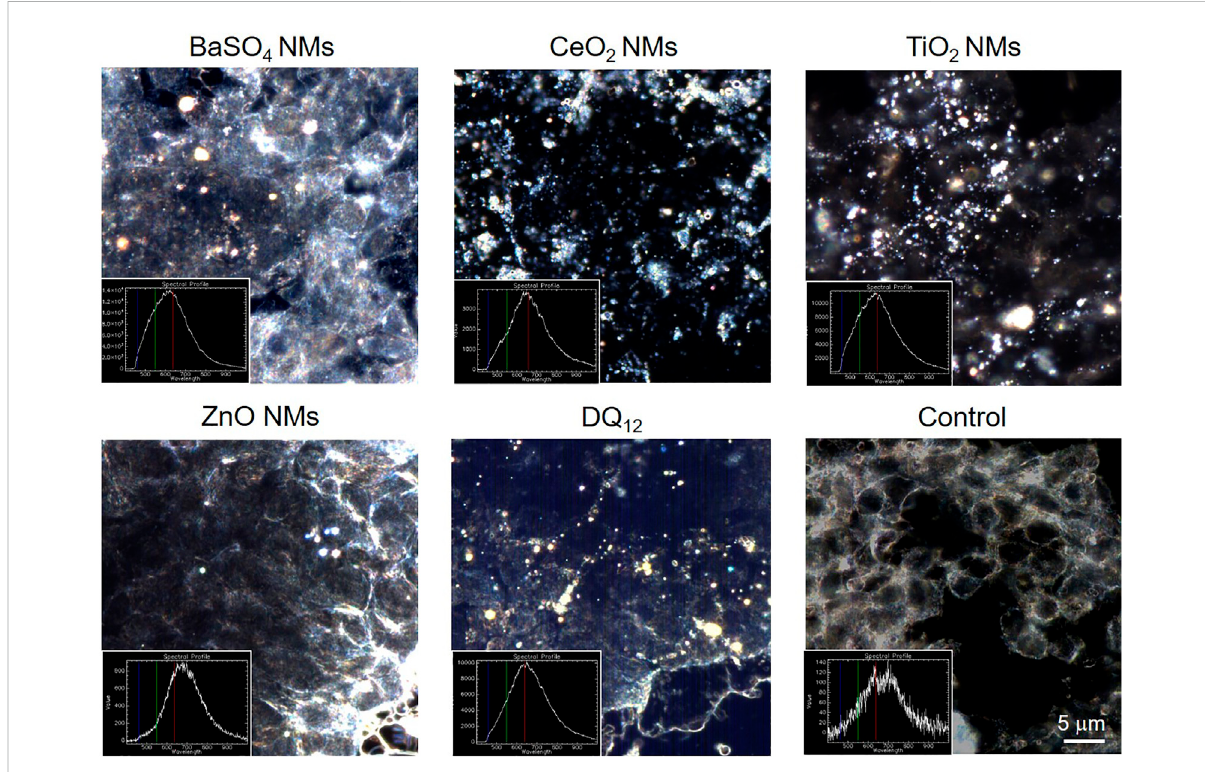
FIGURE 4 Hyperspectralimages of NMsand DQ 12 only and ofA549 epithelial cellstreated with 100 µg/ml for 80 hand thecorresponding spectra. Please note that for some images the focus of the materials and cells do not match and therefore images may look blurry. Scale bar is 5 μ m for all